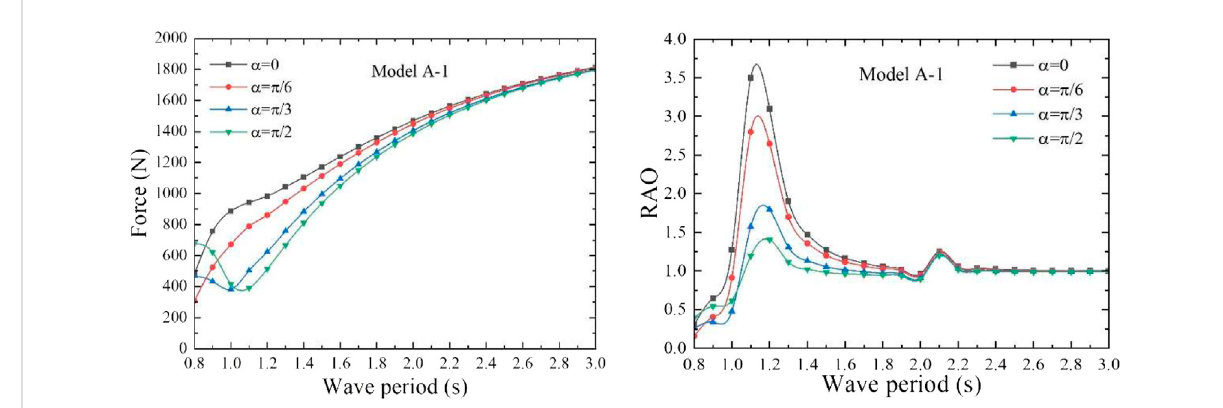
FIGURE 5 Wave force on model A-1 (left) and the heave RAO of it (right).